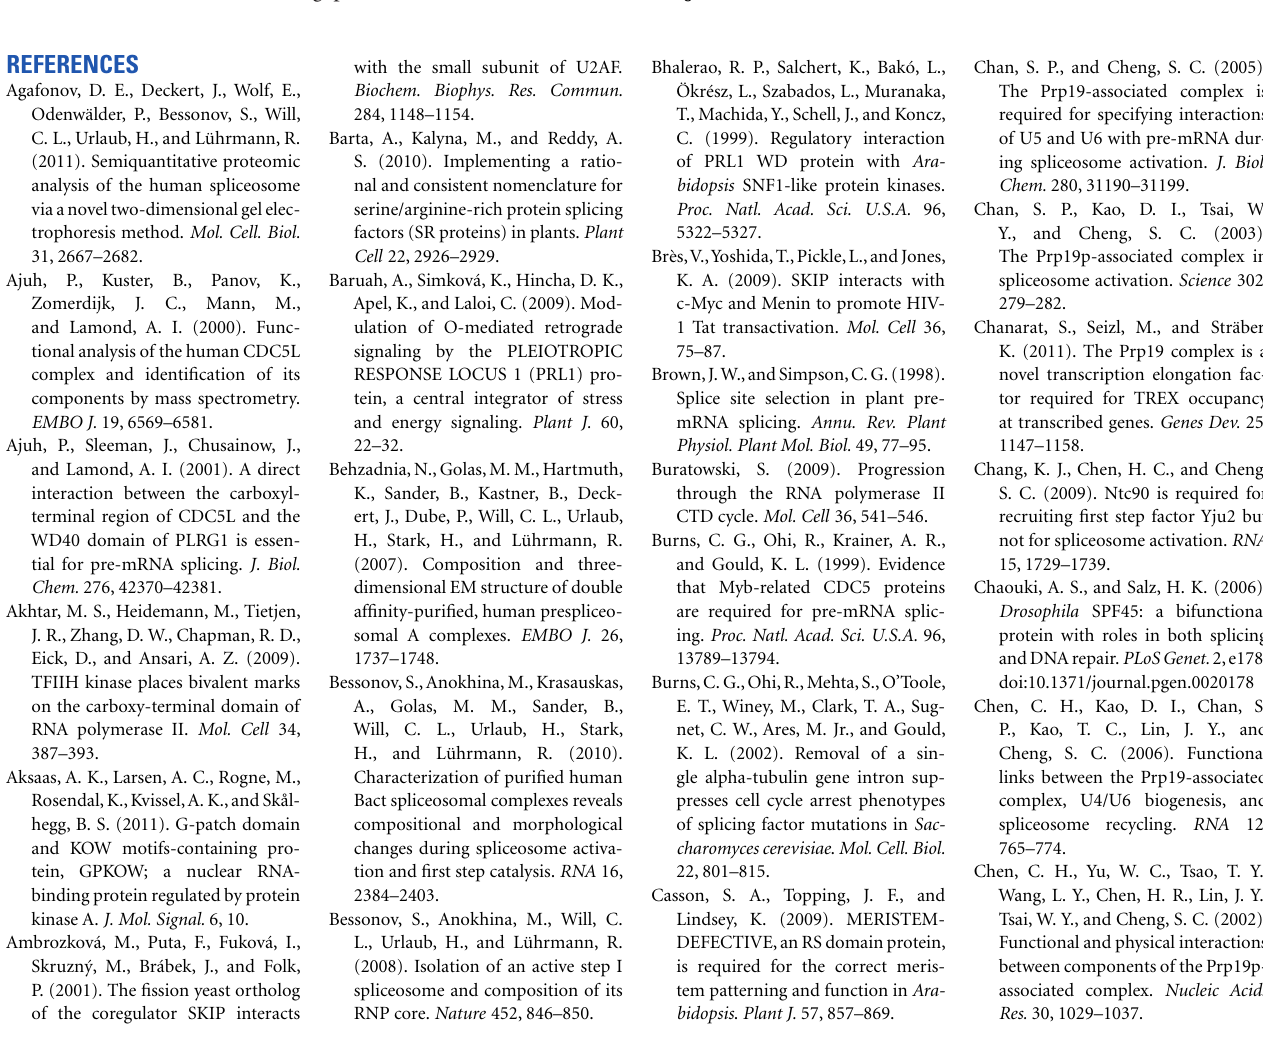
Table S1 | Compilation of mass spectrometry data on protein composition of purified yeast, Drosophila , human, and Arabidopsis spliceosome and